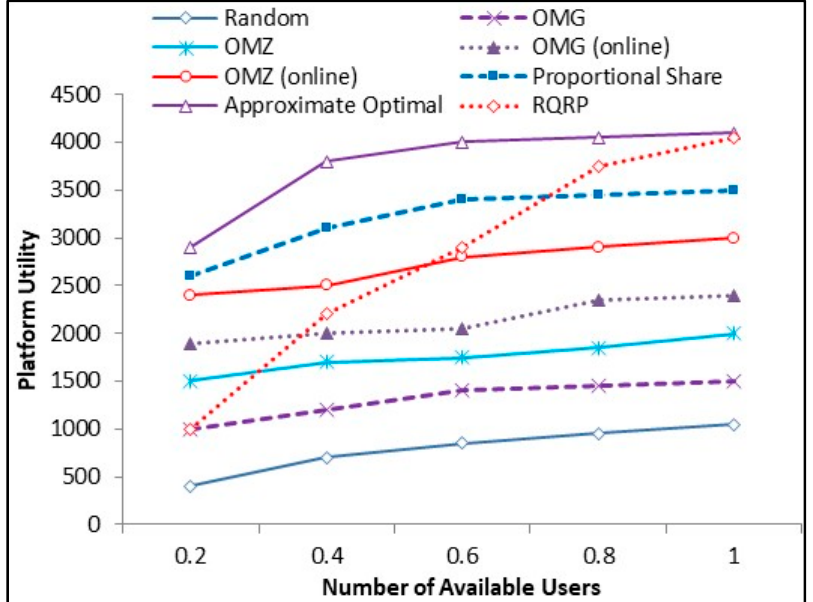
Figure 5. Effect of change in the number of MWs on the platform utility.